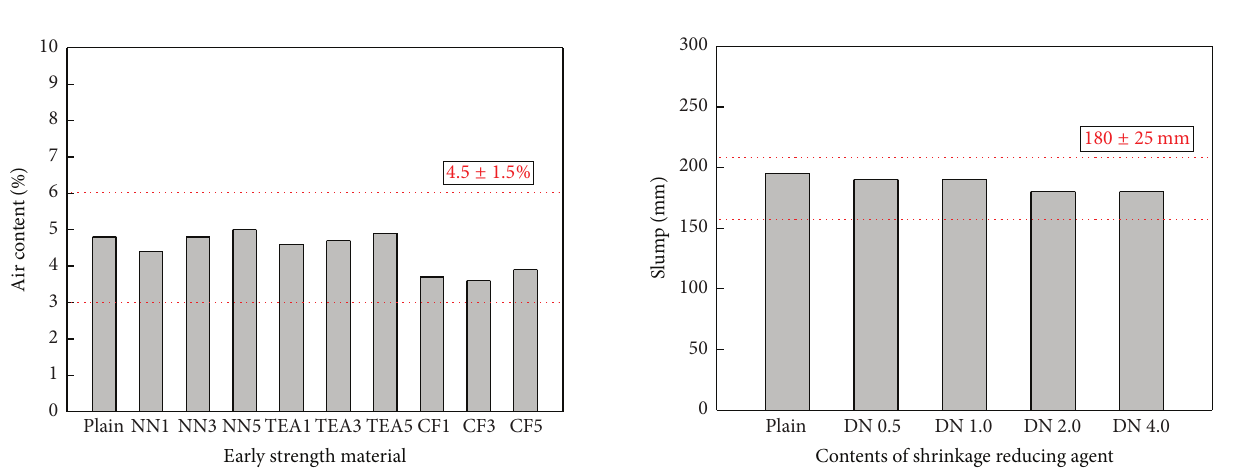
Figure 6: Air content of concrete in relation to the type and amount of early strength material.